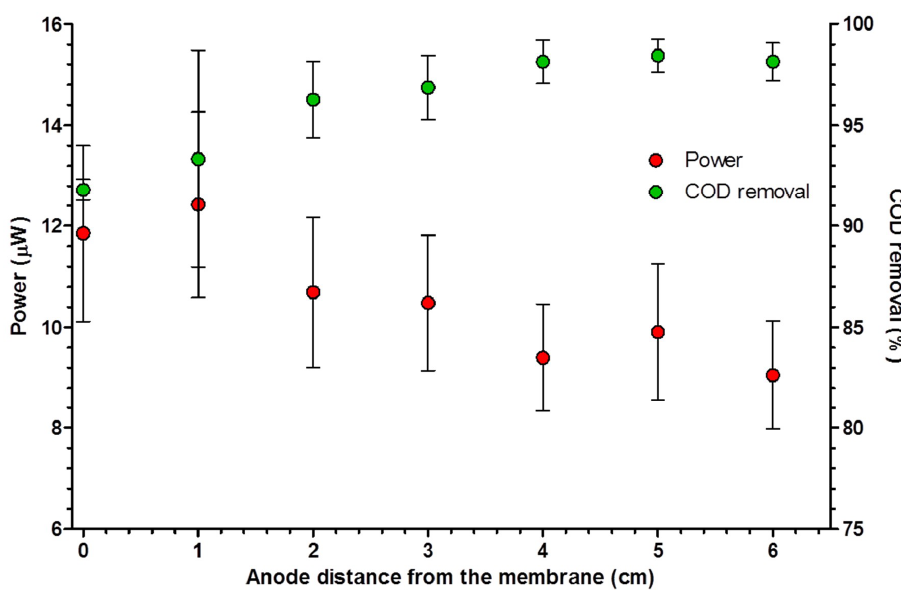
Figure 2. Power output and chemical oxygen demand (COD) removal efficiency with different distance between anode and membrane.